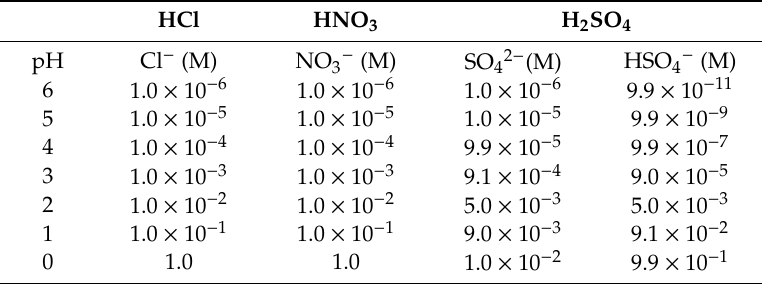
Table 3. Concentrations of various anions used in the study at di ff erent pH’s